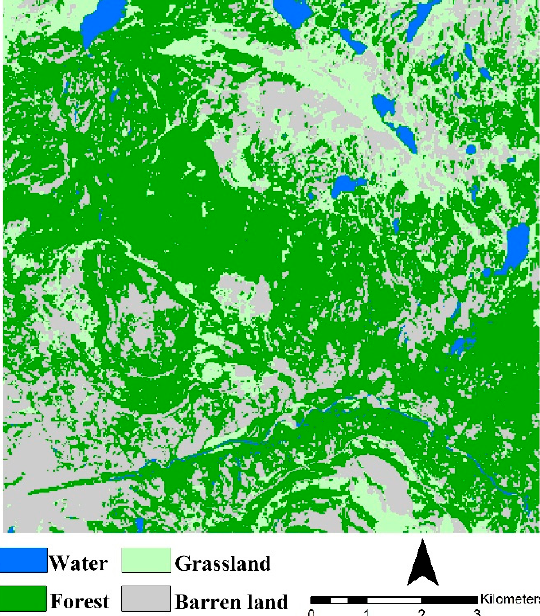
Figure 4. Land cover map for the study areas in 2015.